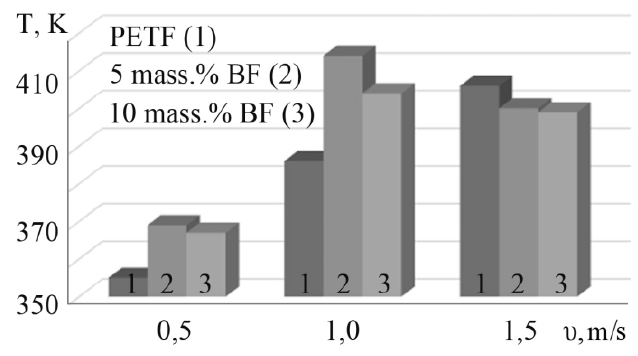
Fig. 3. Dependence of temperature in the contact zone of polyethylene terephthalate and basaltoplastics based